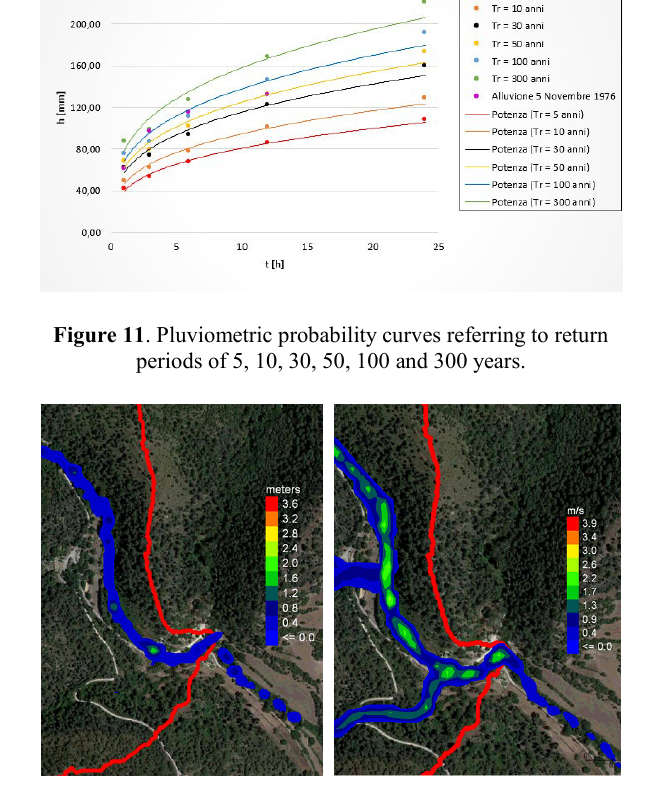
Figure 12 . On the left, maximum height of the flow near the entrance to the hypogeum of Calaforno. On the right, maximum flow velocities along the watercourse near the entrance to the hypogeum of Calaforno.